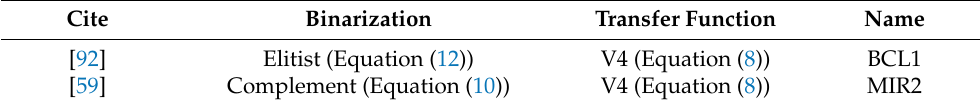
Table 2. Recommended binarization schemes in the